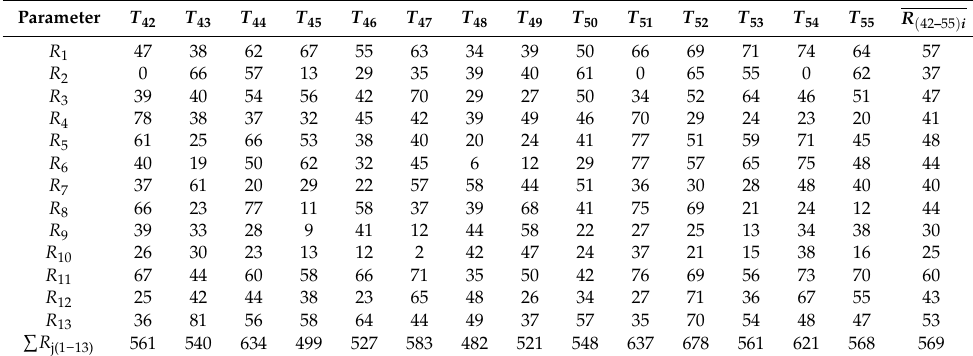
Table A21. Ranking of T j territories on land activity, Volga Federal